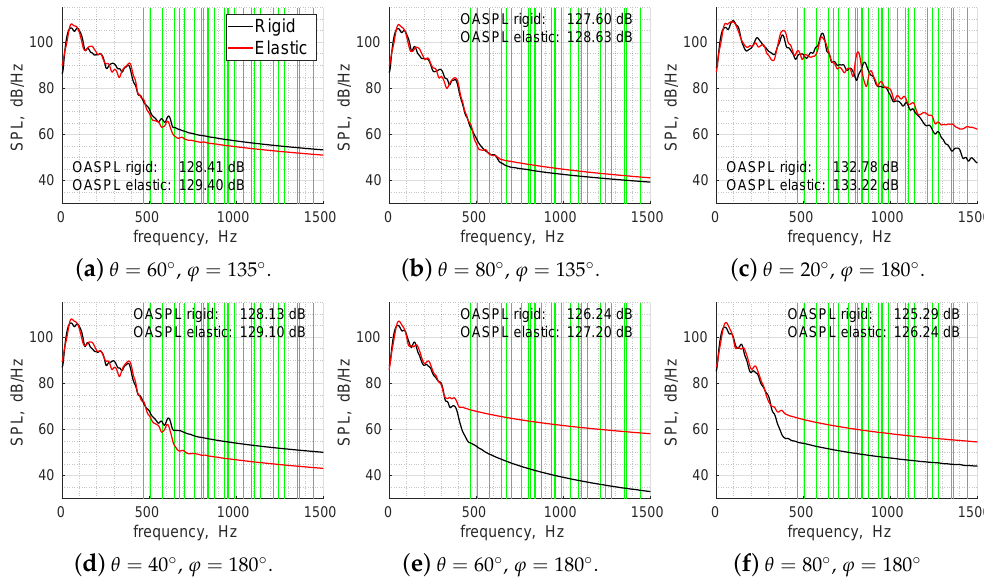
Figure 15. SPL at the microphones. Green vertical lines mark the structural eigenfrequencies.